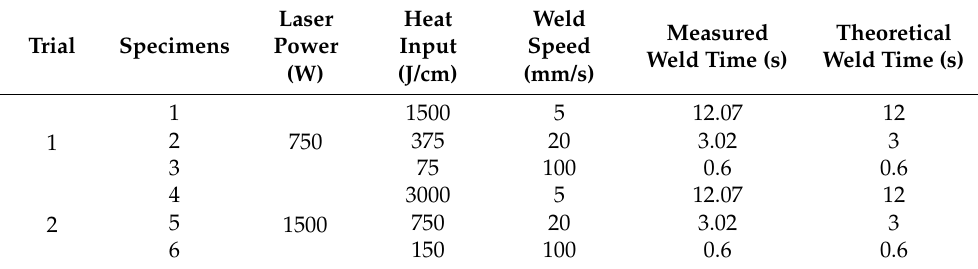
Table 1. Process parameters used for the LW experiment.